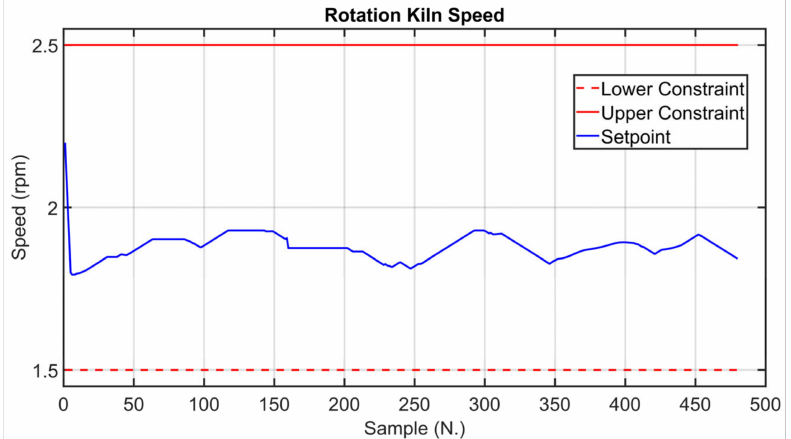
Figure 18. Rotary kiln APC system: virtual environment simulations results (rotation kiln speed